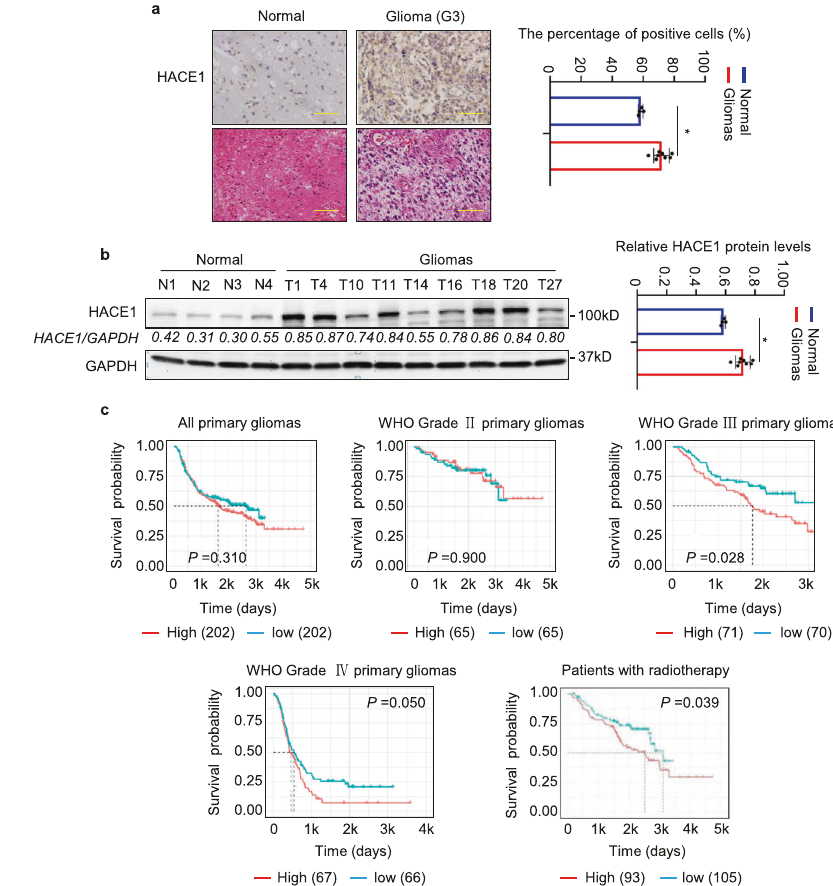
Fig. 1 Correlation between increased expression of HACE1 and poor prognosis in LGG patients. a Left panel: immunohistochemistry staining (×40) showing HACE1 expression in paraf fi n-embedded gliomas ( n = 9) and normal brain tissues ( n = 4). Right panel showing quantitative illustration of HACE1 proteins. Scale bars, 200 μ m. b Left panel: western blot analysis of HACE1 expression in fresh-frozen gliomas ( n = 9) and normal brain tissues ( n = 4). GAPDH as a loading control was used to normalize protein levels of HACE1 using the Tanon GIS 1D analysis software. Right panel showing statistical analysis of HACE1 proteins. c The correlation between HACE1 expression and poor prognosis in glioma patients by using R-Studio and X-tile (data from CGGA data set). Data were expressed as mean ± SD. * P <